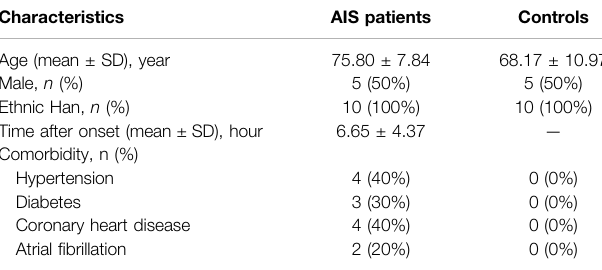
TABLE 1 | Demographic characteristics of AIS patients and